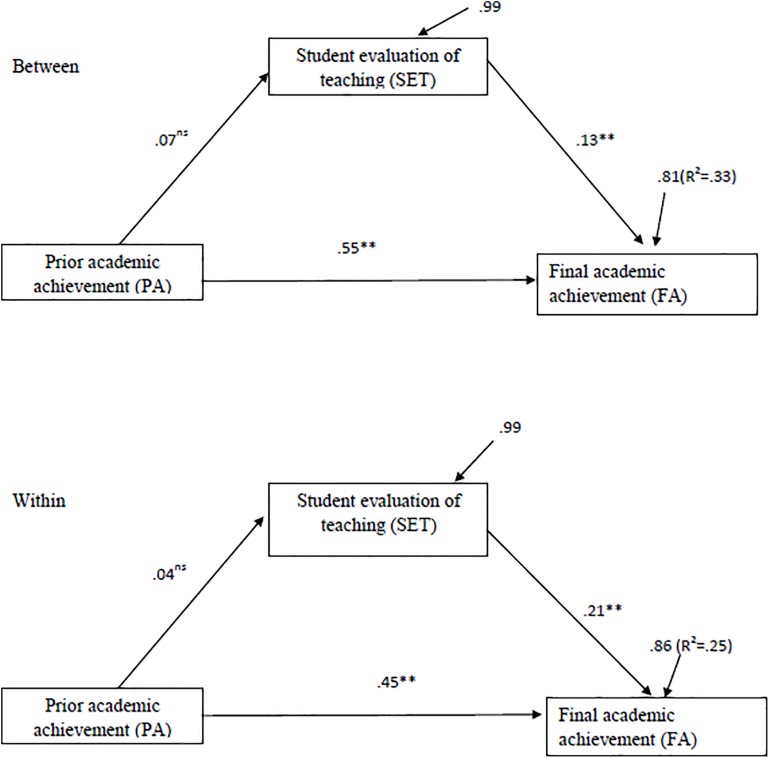
Standardized coefficients of the multilevel model with between prior academic achievement (V1), SET (V3), and academic achievement (V2). Path coefficients constrained to be equal. ∗∗p < 0.01; ns = not significant.